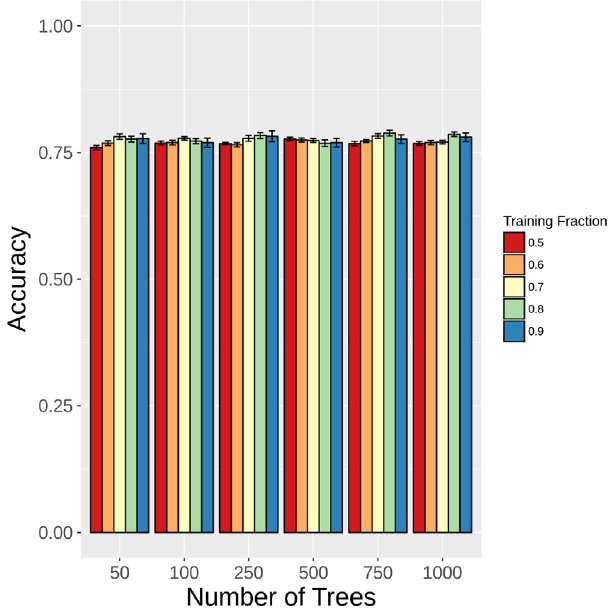
FIG. 5. Average accuracy of the model for various training fractions and number of trees in the forest. Error bars correspond to a standard